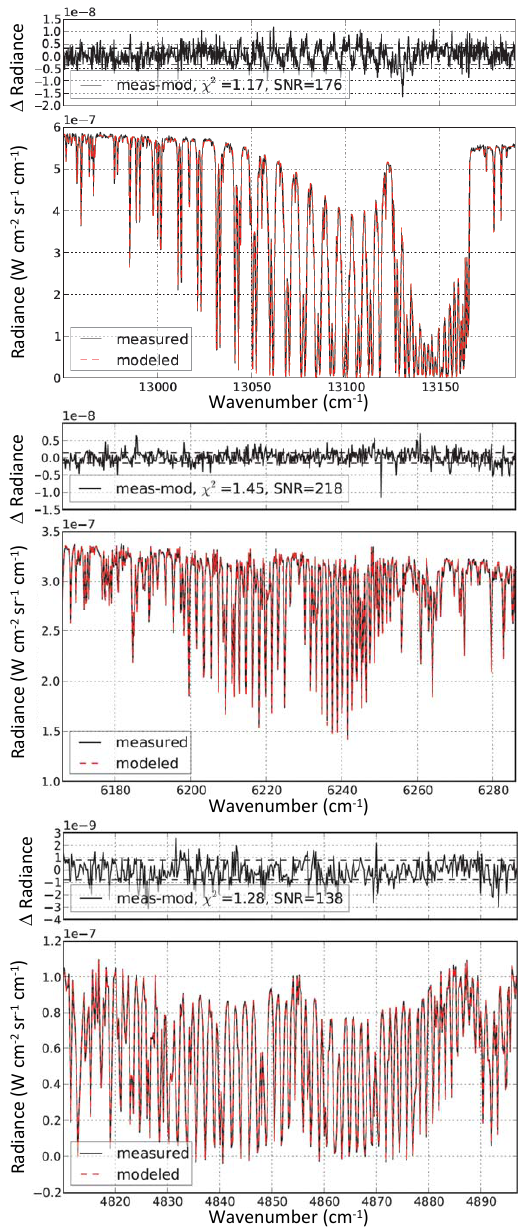
Crisp Fig. 4 , surface pres- 2